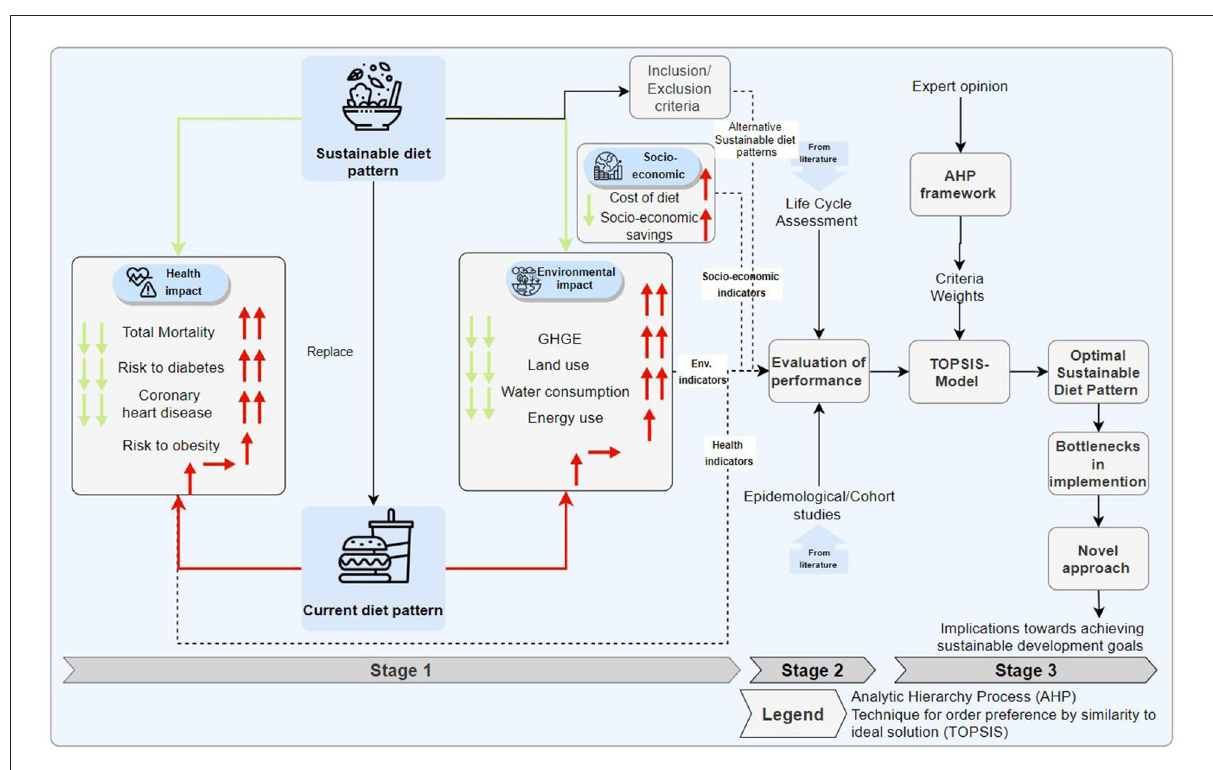
FIGURE1 Conceptual framework for determining the performance of sustainable diet concepts in the United